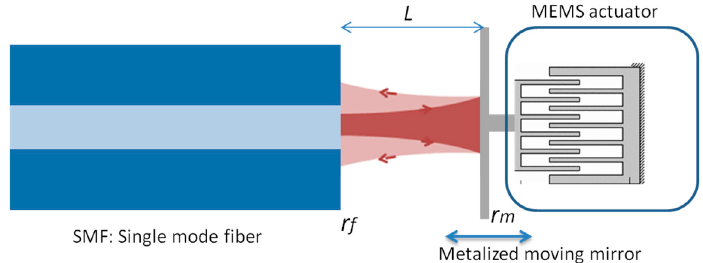
Figure 10. Schematic representation of the fiber Fabry-Perot interferometer with metalized moving mirror connected to MEMS actuator